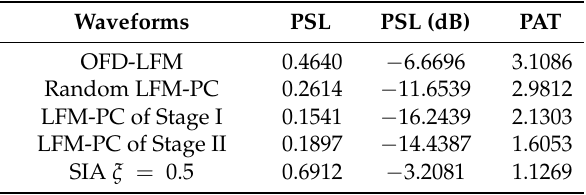
Table 7. Optimization results for the